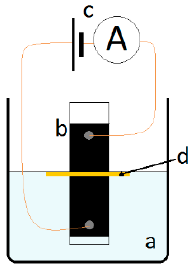
Figure 2. A schematic of the detector response rate measurement set up, ( a ) deionized water, ( b ) sample strip on polyethylene terephthalate (PET) foil, ( c ) DC power supply and multimeter connected to the sample with copper wires, ( d ) oil droplet on water surface.